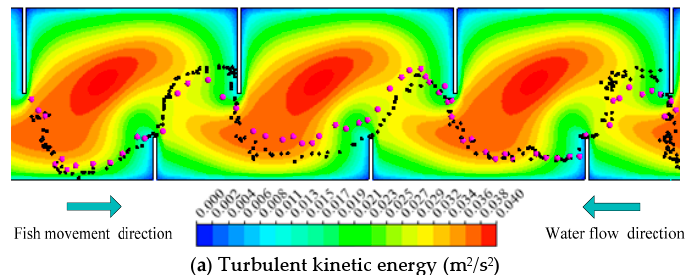
Figure 7. Representative trajectory of Fish B combined with ( a ) TKE; ( b ) V; ( c ) SR distribution in Pools 2–4 (Notes: The rose red points represent the simulated fish movement trajectories, and the black points represent the measured trajectories of fish).